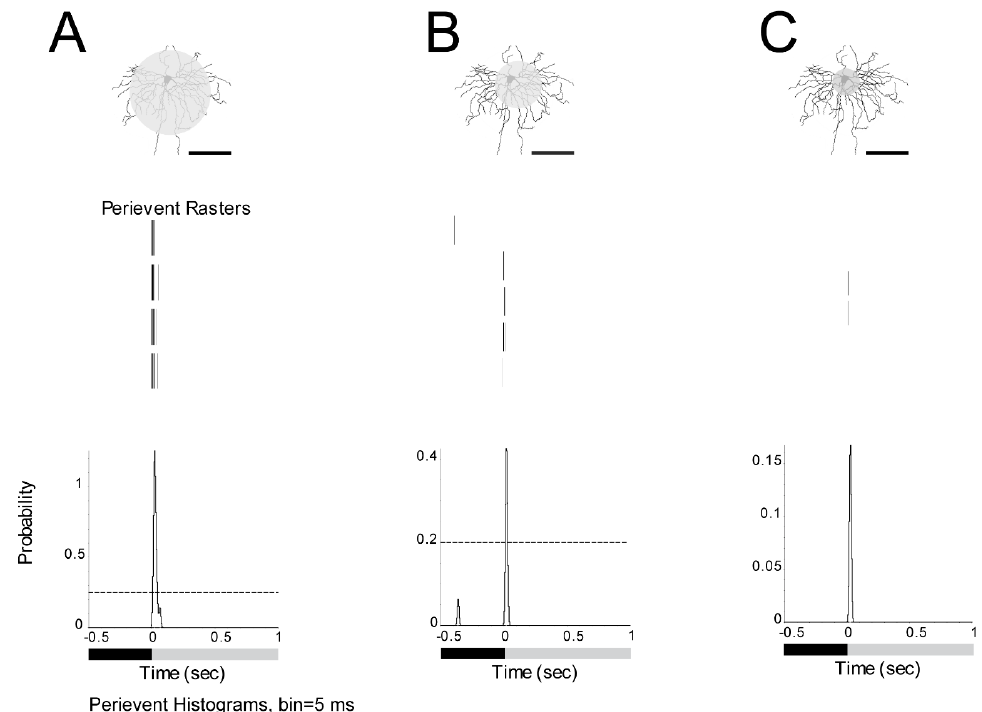
Figure 3. Dark-adapted ON α -RGCs show decreasing spikes to smaller light spot stimuli. A : ON α -RGC response to a 125 µ m light spot. B : The peristimulus time histogram shows the decreased probability of spikes to a 75 µ m light spot. C : The peristimulus time histogram shows that the cell almost lost the light response to a 50 µ m light spot. Therefore, a 125 µ m light spot was used in the subsequent experiments. (1 s light stimulation). Scale bar: 75 µ